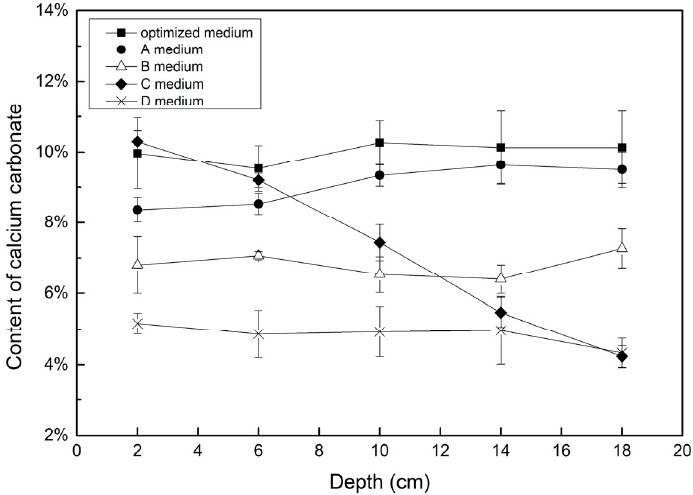
Figure 9. Calcium carbonate content distribution.